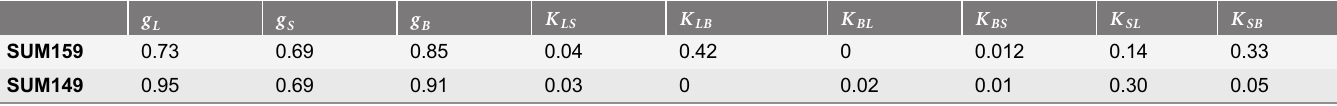
g L , g B , g S are growth rates of the subpopulation Luminal, Basal and cancer stem cells. K ij , i ~ L , B , S ; , j ~ L , B , S ð Þ are transition rates between two breast cancer cell